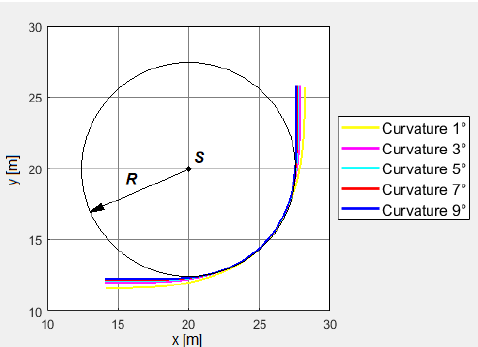
Figure 4. The trajectories “half of lambda” (HoL) for the bi-curves whose curvature is described by the linear function as well as the third, fifth, seventh, and ninth degree polynomials.